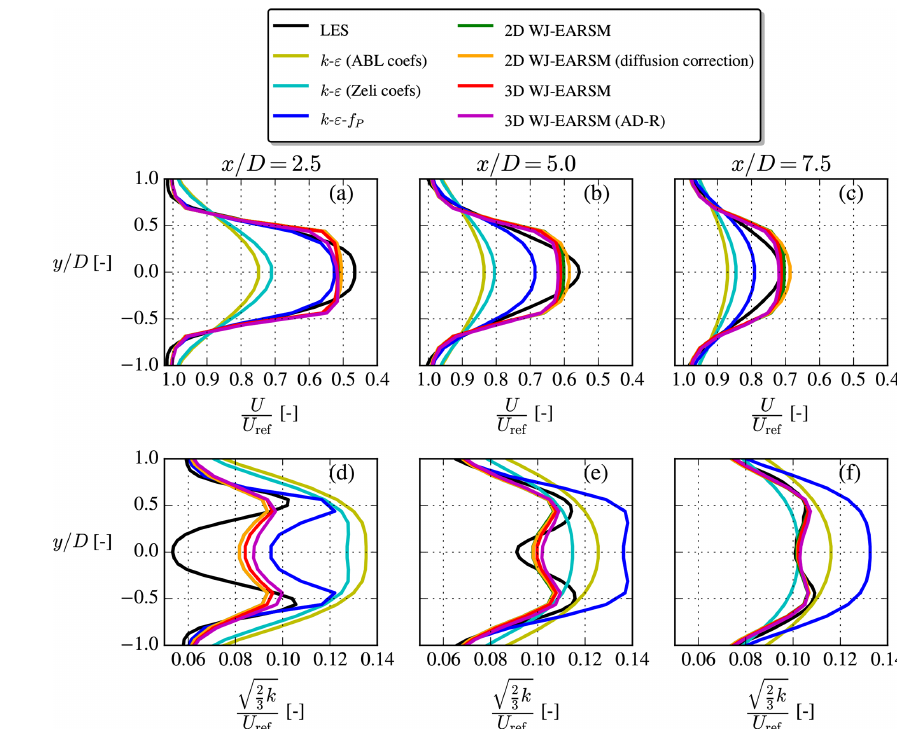
Figure 15. Streamwise velocity (a–c) and TI (d–f) profiles extracted at various downstream positions for the single-wake V80 case.